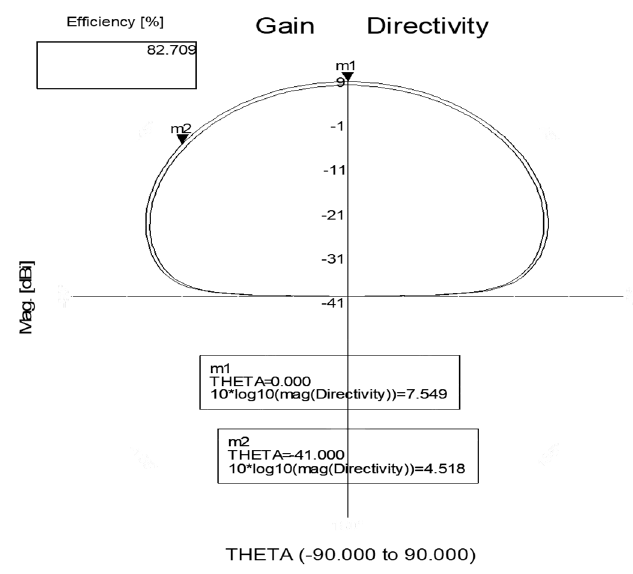
Figure 4. Radiation pattern of the 2.6 GHz circular microstrip antenna with CSRR.